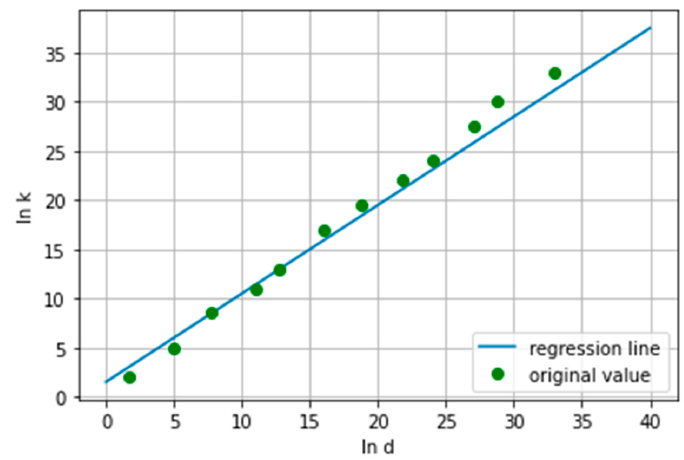
Figure 3 . Dependence of the size of cells on their number for material 2 .